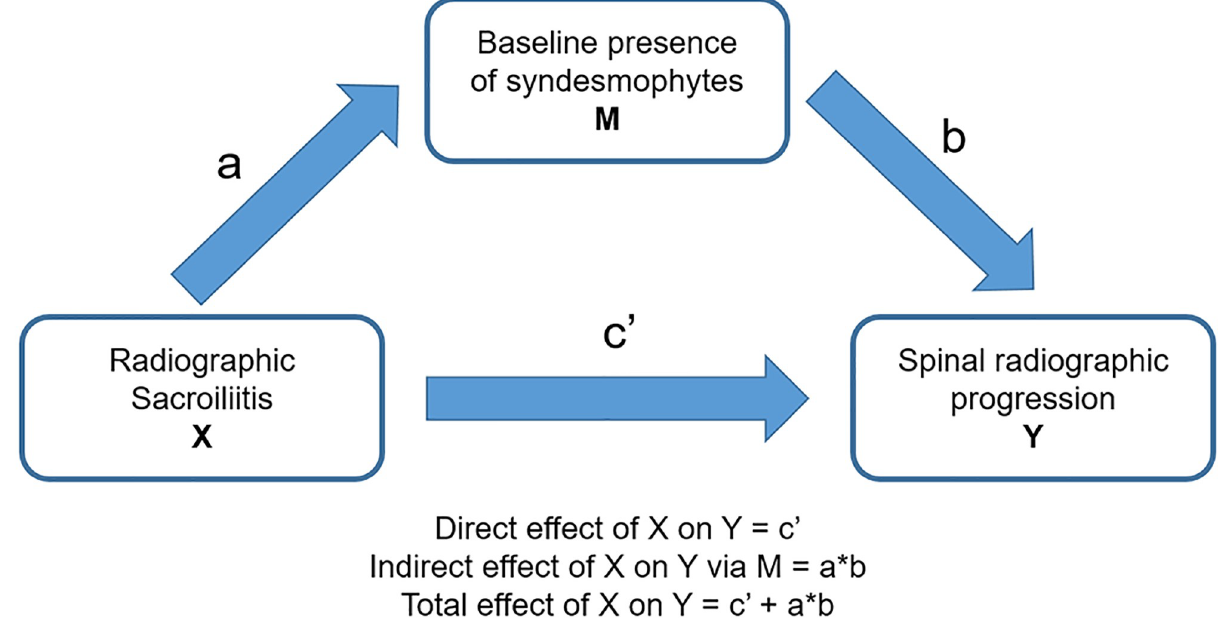
Fig 1. Potential impact of radiographic sacroiliitis on spinal progression. The diagram represents the putative effect of radiographic sacroiliitis (X) on spinal radiographic progression (Y), either directly or indirectly via affecting the baseline presence of syndesmophytes (mediator, M).